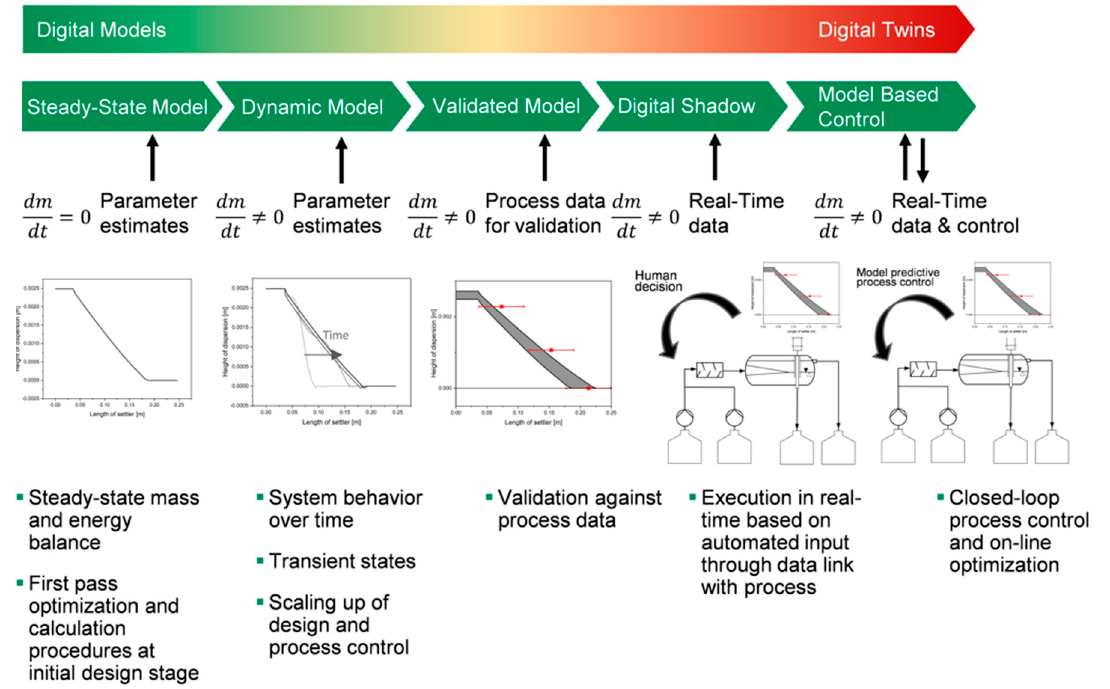
Figure 2. Schematic and qualitive illustration of the development path from a stationary model to a digital twin with the example of the mixer–settler [9].